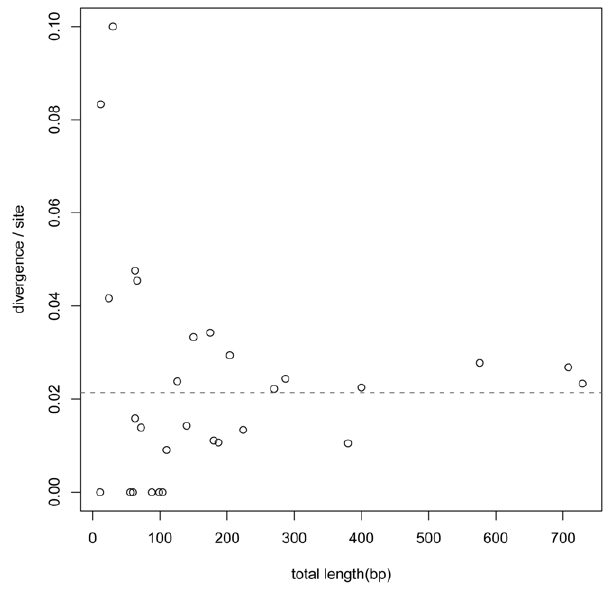
Figure 1. TFBS divergence for 30 TF. TFBS divergence for 30 TFs is plotted as a function of the total number of nucleotides assigned as binding sites to that TF. A maximum likelihood estimate of the mean divergence is marked by the dashed line. Individual binomial tests find no evidence for heterogeneity in divergence rates among the 30 TFs (0.05 significance level, with Bonferroni correction for multiple